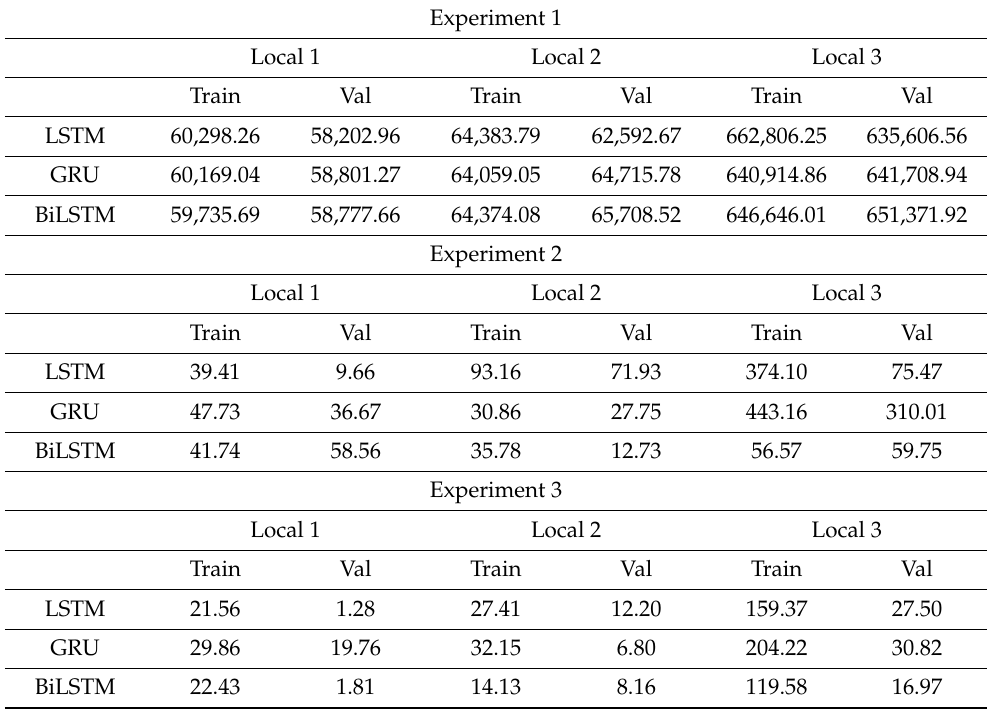
Table 2. Final training result for experiments